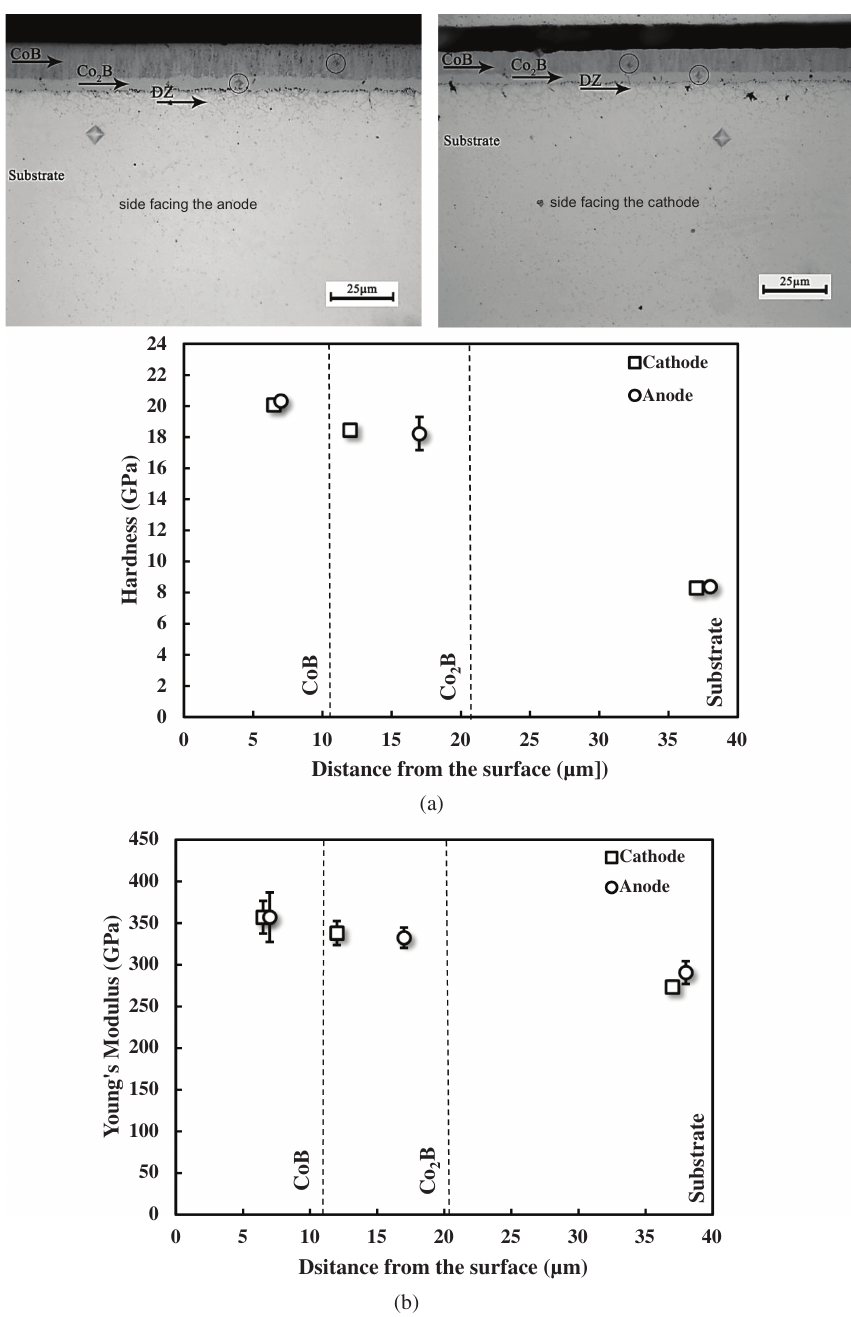
Figure 8: (a) Plots of the hardness-depth profiles across the cobalt boride layers developed at 1148 K with 2 h of exposure. (b) The Young ’ s modulus ( E ) of the CoB and Co 2 B against the distance from the borided surface. The PBDCF condition was 1148 K with 2 h of